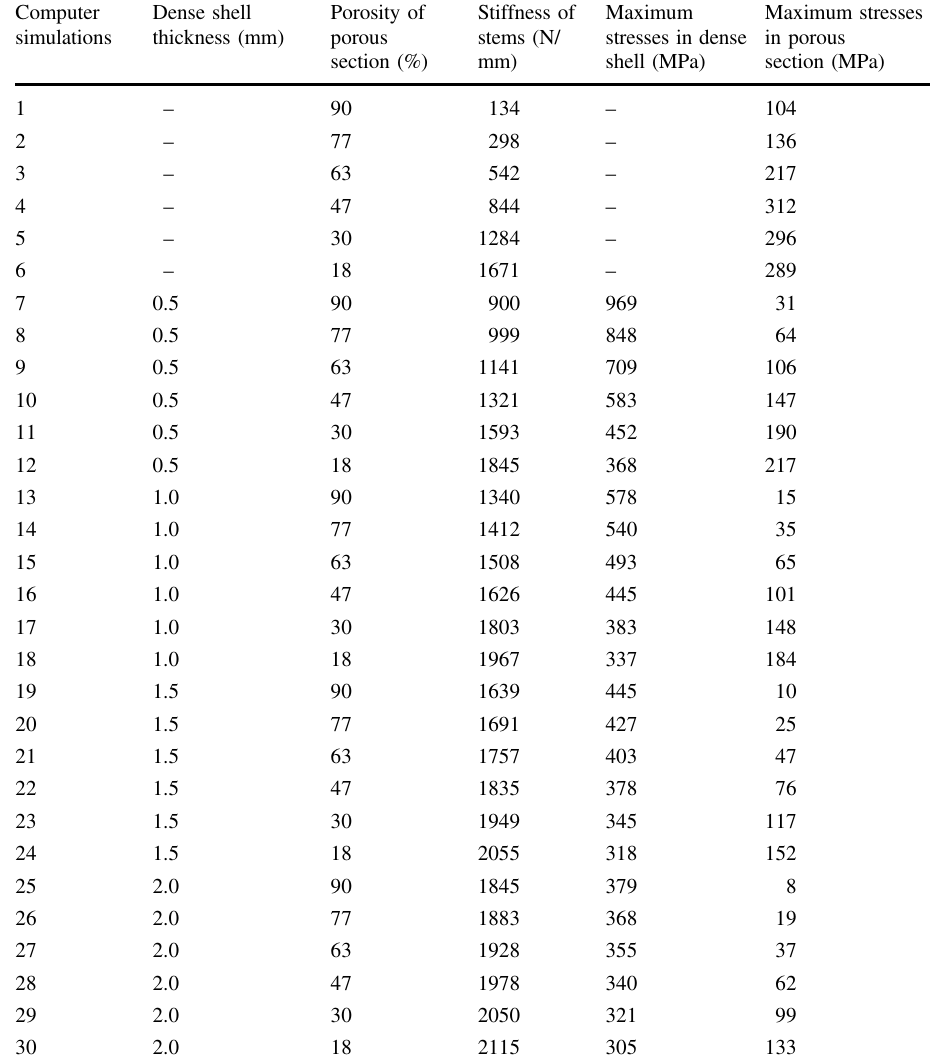
Table 2 Design of experiments (DOE) of computer simulations for porous